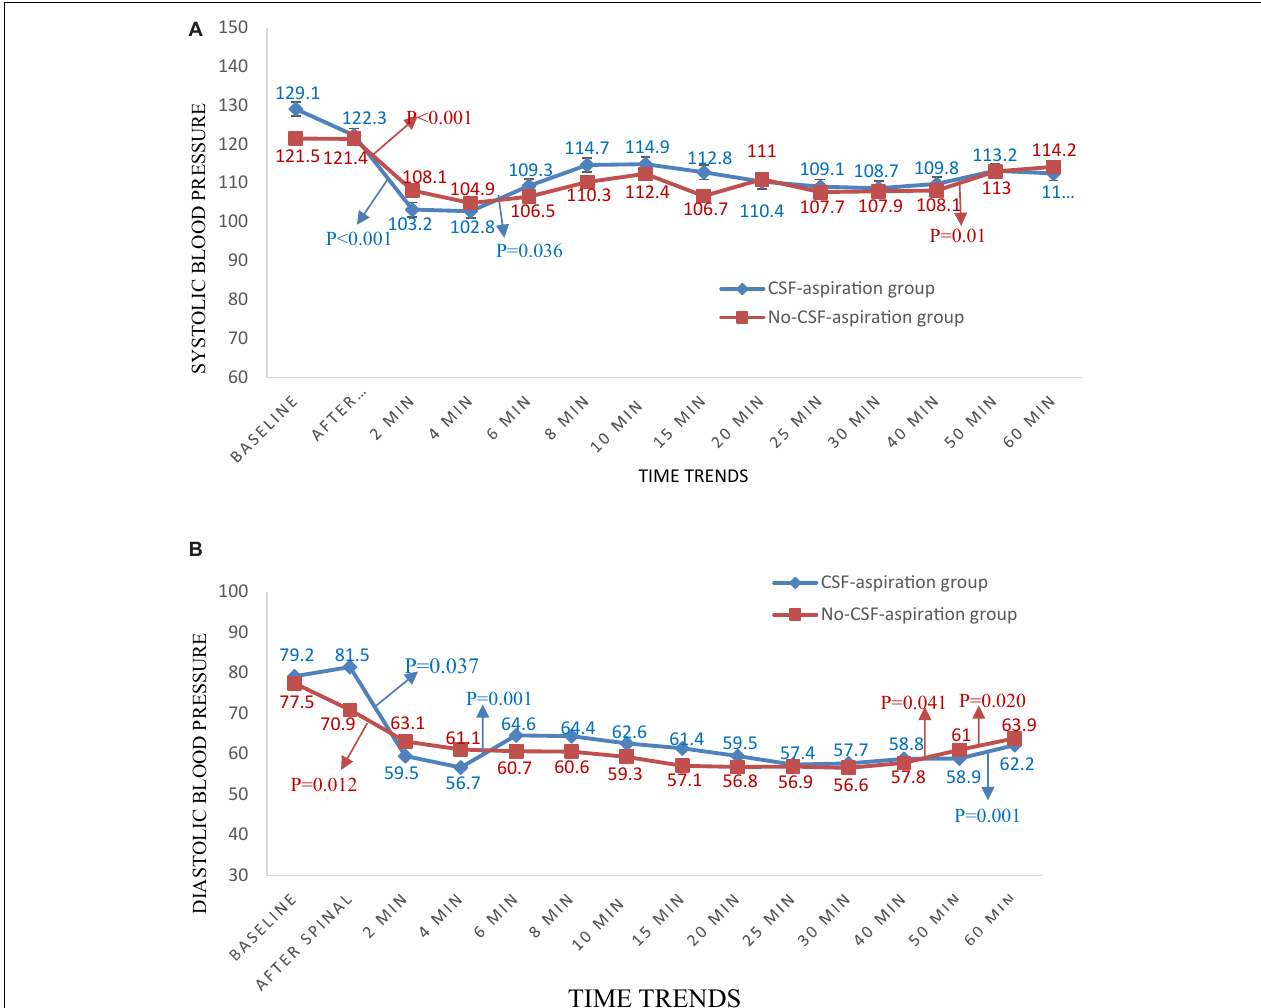
FIGURE 2 | Changes (A) systolic and (B) diastolic blood pressure in two groups of study over times, * P -values shows statistically significant between two times within groups.